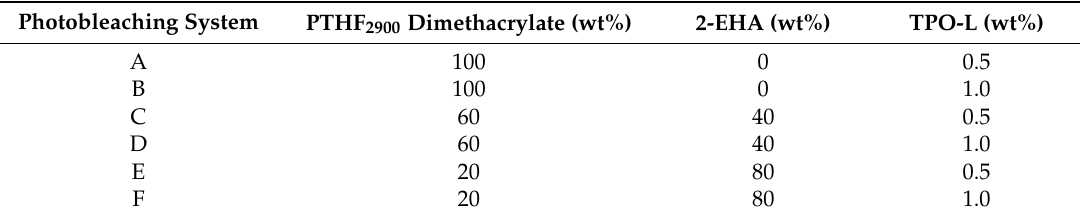
Table 3. Photobleaching systems for specimen production containing 0.5 / 1.0 wt % TPO-L and varying ratio of PTHF 2900 -DM and 2-ethylhexyl acrylate.